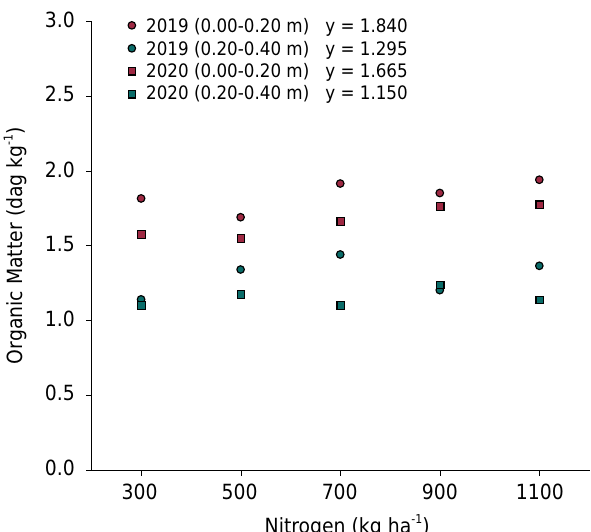
Figure 4. Organic matter contents at layers of 0.00-0.20 and 0.20-0.40 m in the soil cultivated with Conilon coffee, in response to the application of nitrogen